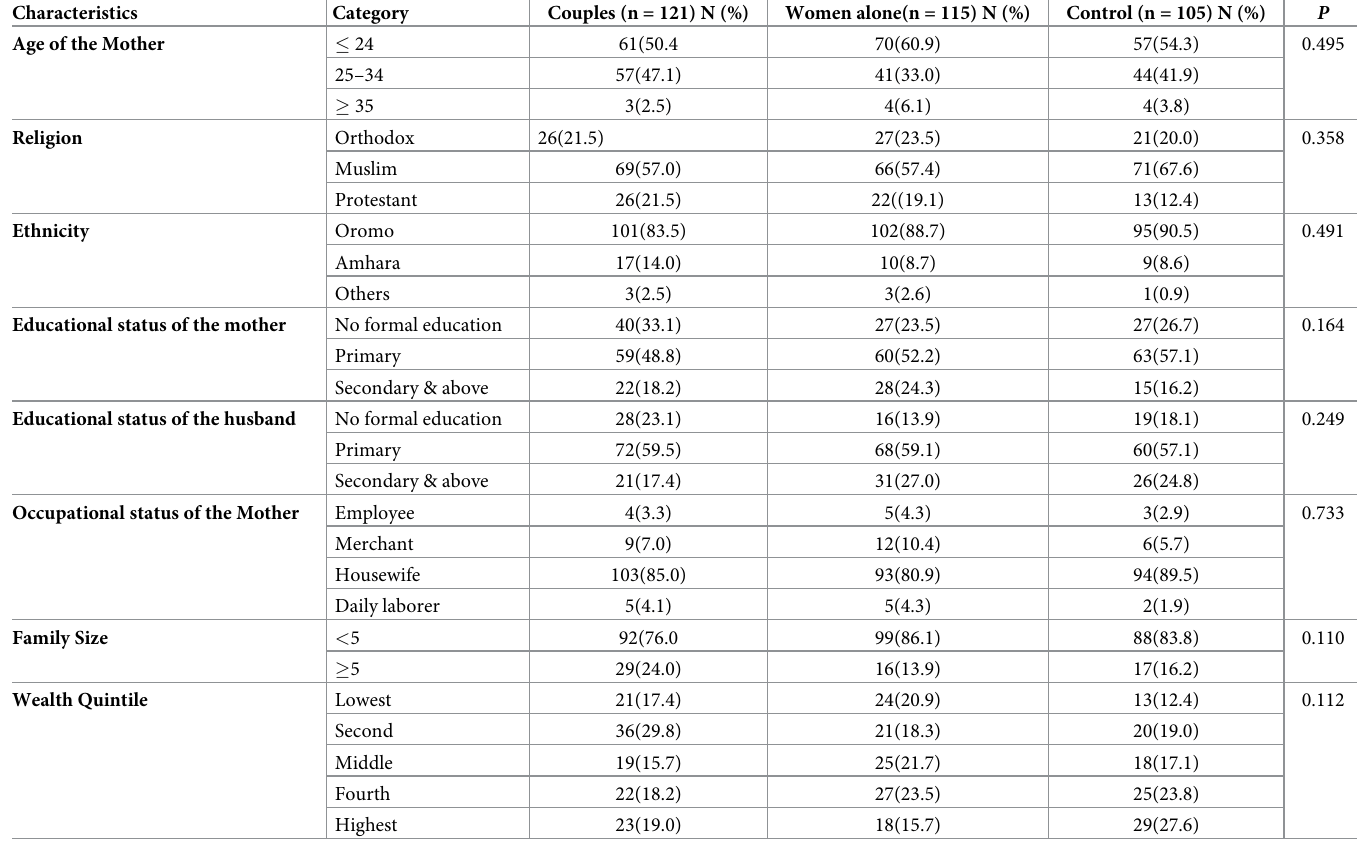
Table 1. Baseline socio-demographic and economic characteristics of the pregnant women in Illu Aba Bor zone, Southwest Ethiopia, 2019.